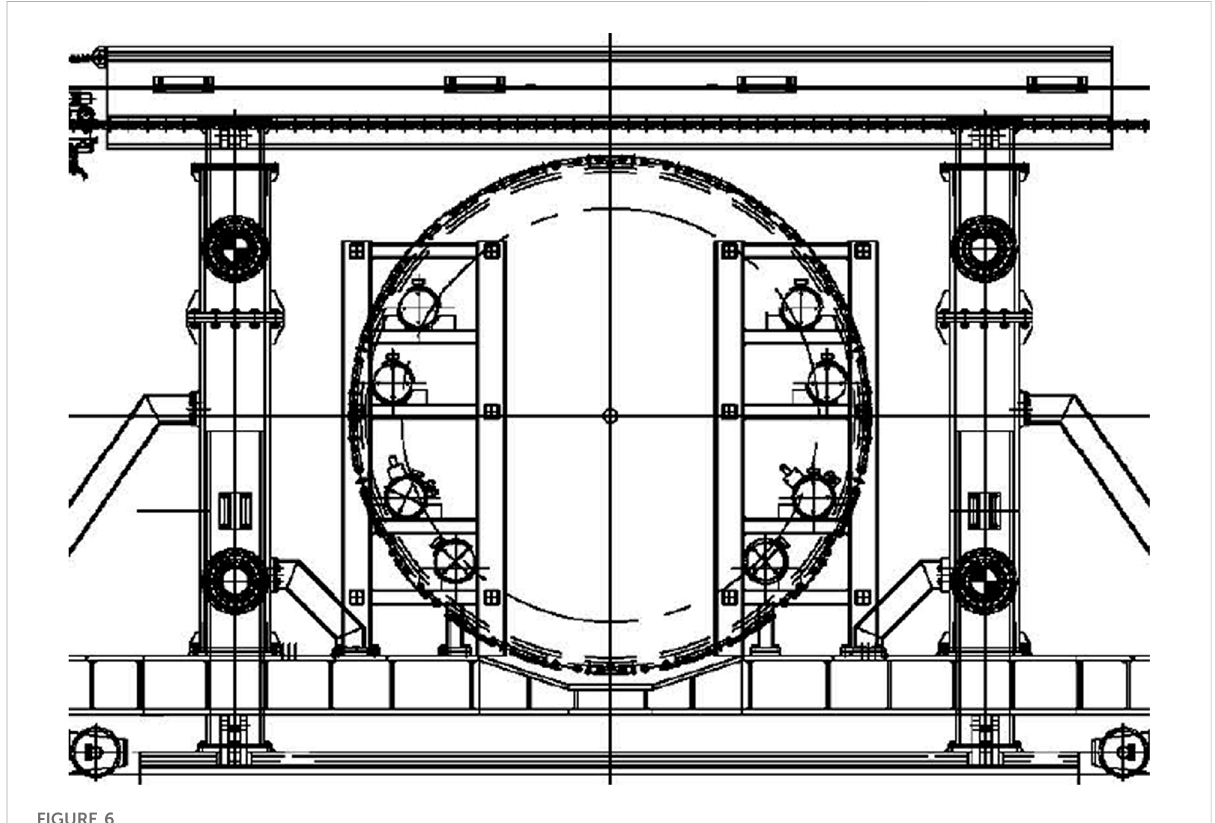
FIGURE 6 Propulsion jack